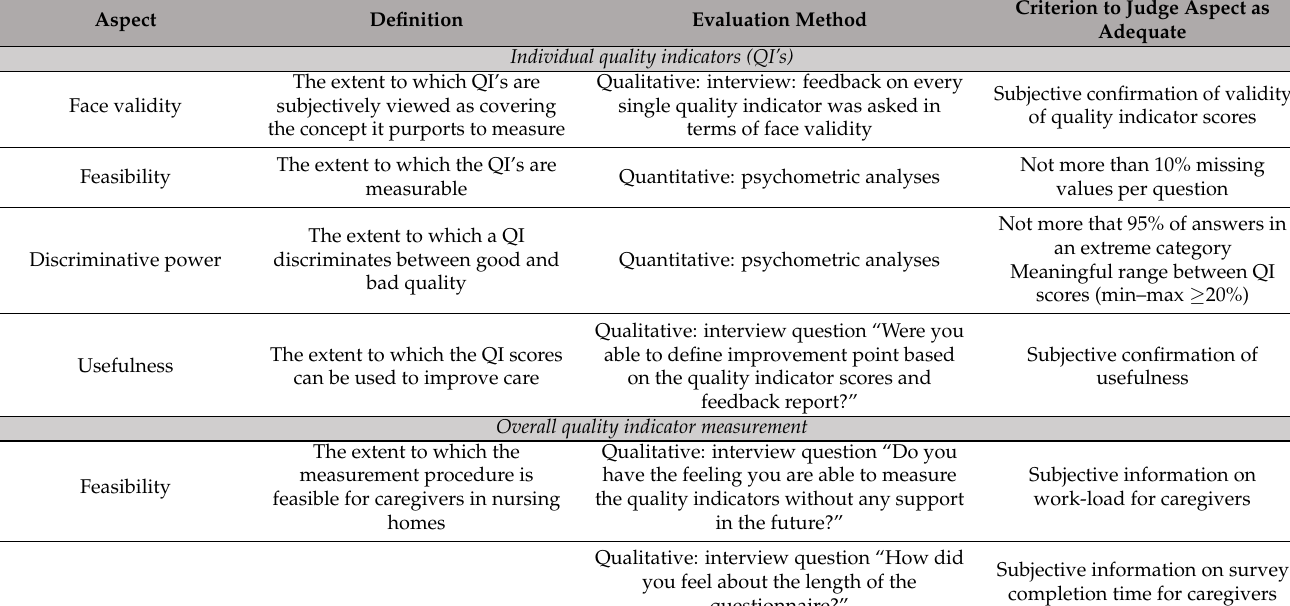
Table 1. Overview of the evaluation and accompanying methods and